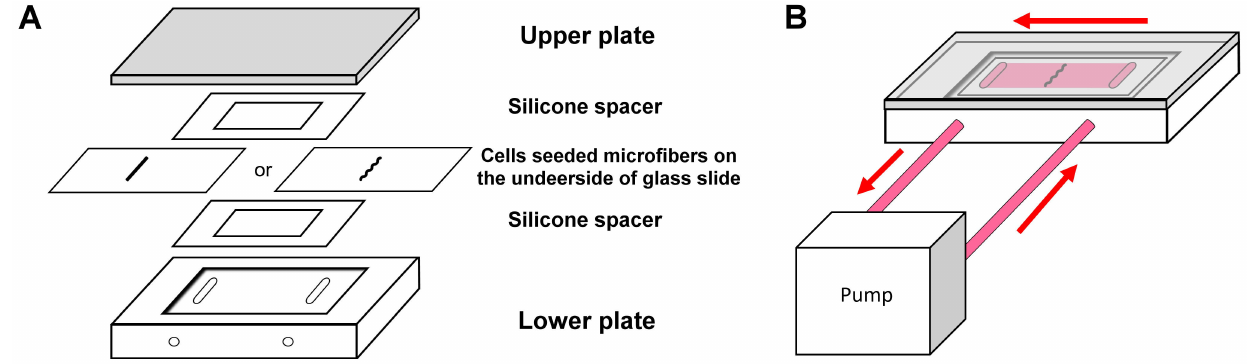
Figure 2. The designation of experiments. ( A ) The set-up of the parallel-plate flow chamber. ( B ) The set-up of the